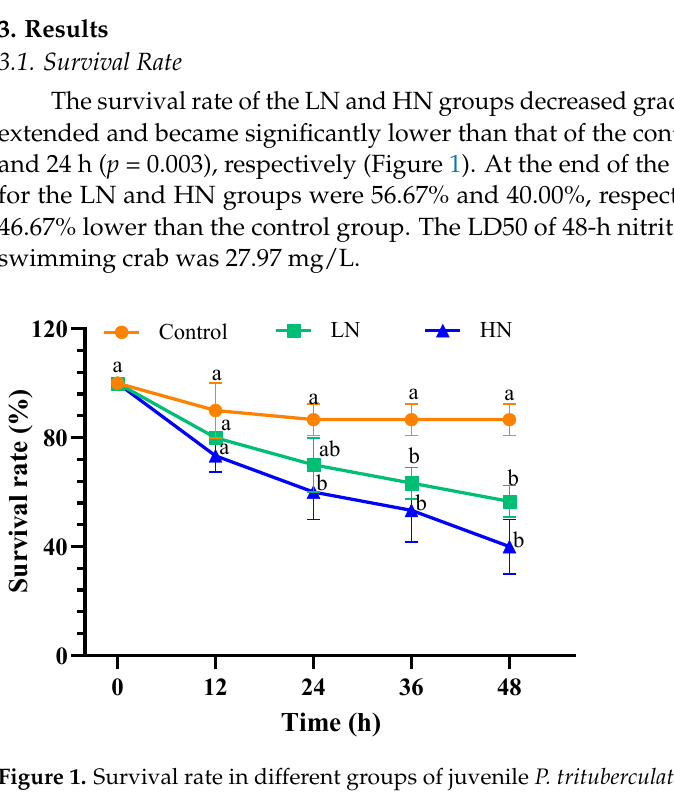
Figure 1. Survival rate in different groups of juvenile P. trituberculatus under nitrite stress. At each time point, the letters indicate significant differences between experimental groups ( p < 0.05).